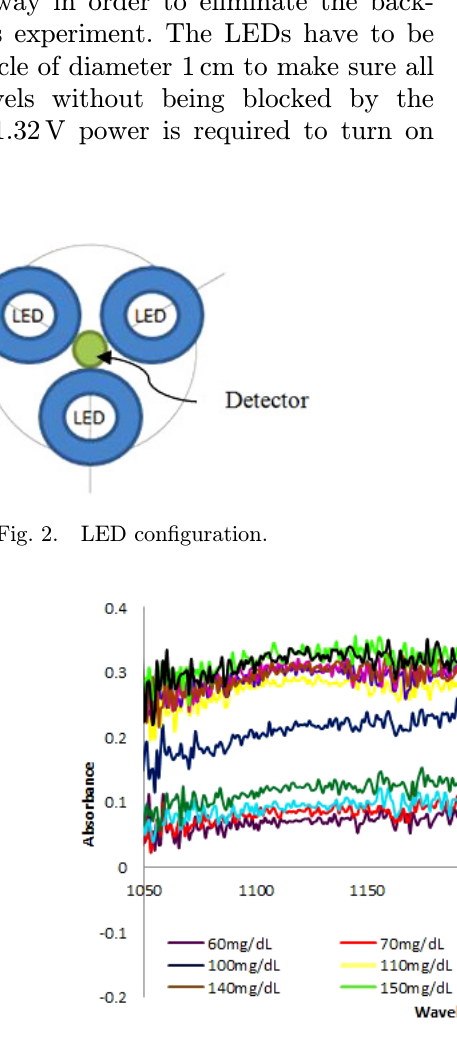
Fig. 3. Absorbance spectrum with various glucose